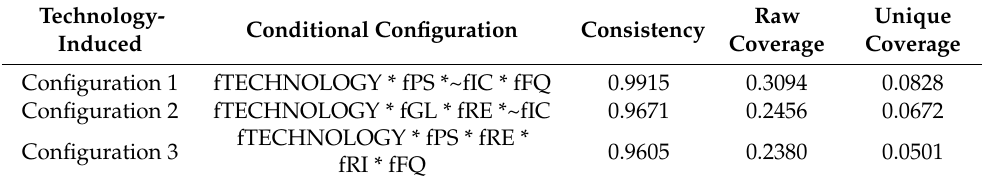
Table 6. Conditions of application of technology-induced